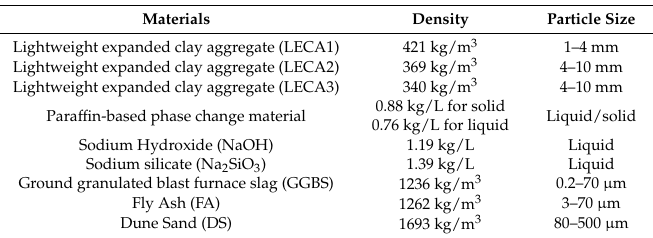
Table 2. List of materials used in the